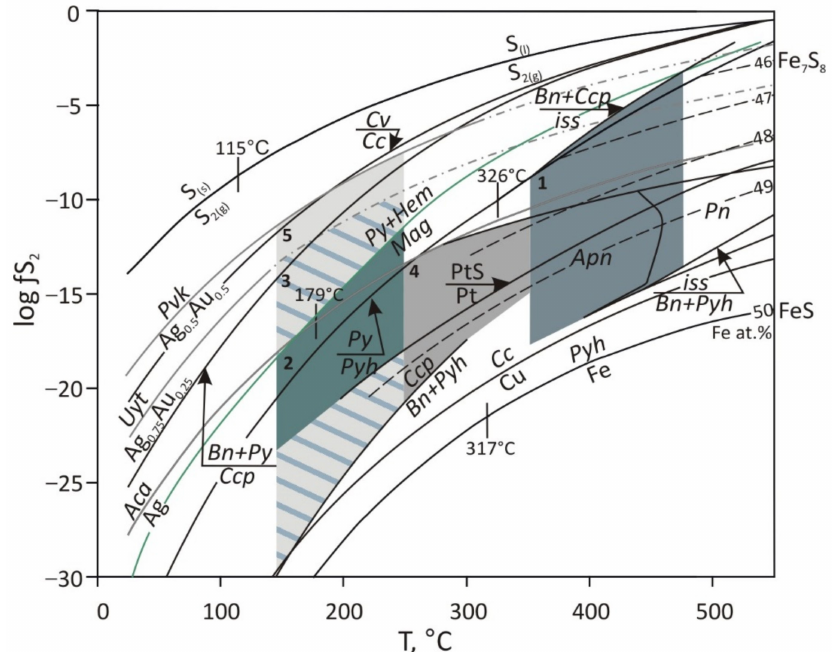
Figure 15. Sulfur fugacity dependence on temperature for Fe-S-O, Cu-Fe-S, Au–Ag–S, and Pt-S systems, and log f S 2 and T estimations for different associations at Ozernoe occurrence. Minerals: